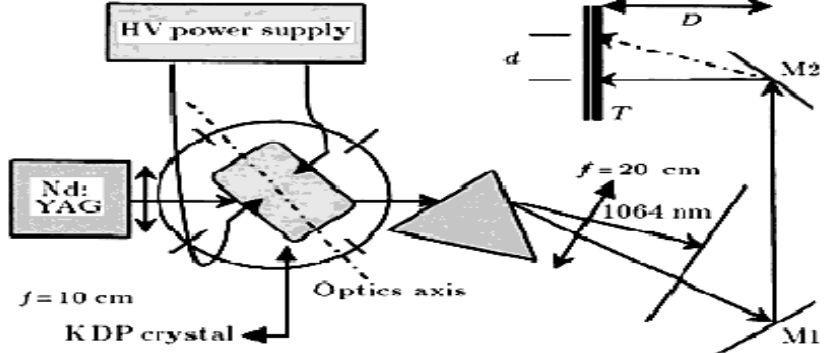
Figure 5. Experimental setup for SHG